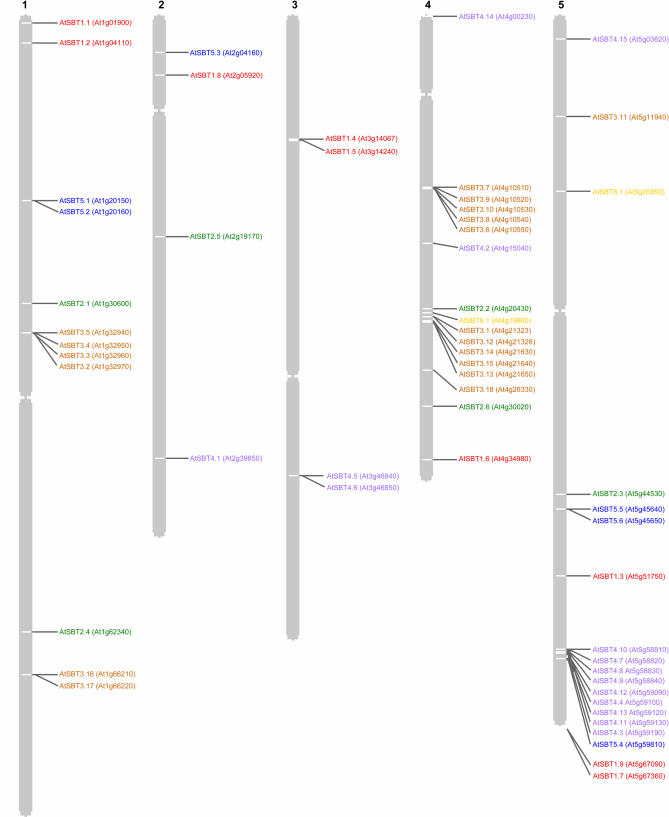
Physical Map of AGI at TAIR Indicating the Chromosomal Distribution of the AtSBT FamilyThe AtSBT genes are localized throughout the Arabidopsis genome as single genes or in tandem repeats.